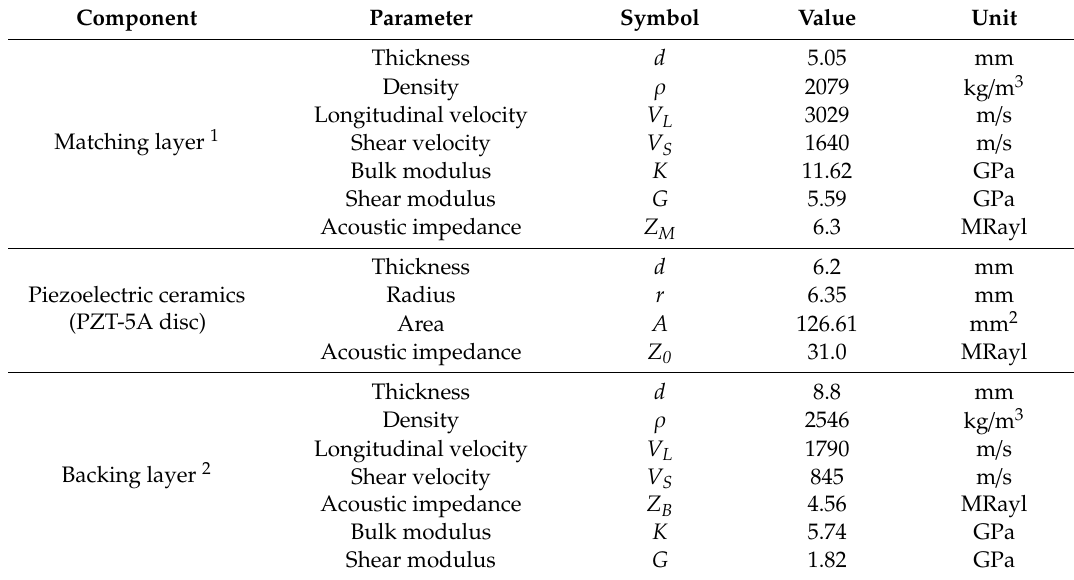
Table 2. Parameters of piezoelectric transducer